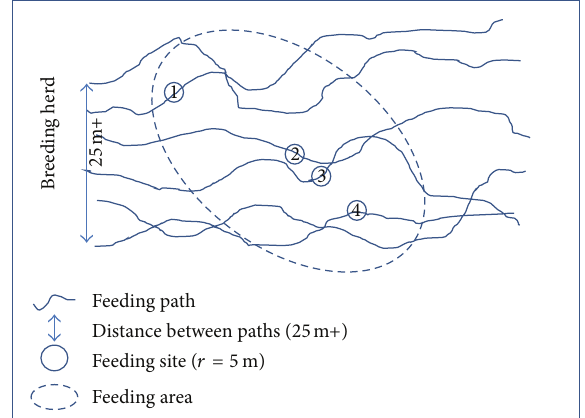
Figure 1: A diagram illustrating sampling methodology, that is, feeding paths, feeding area and feeding